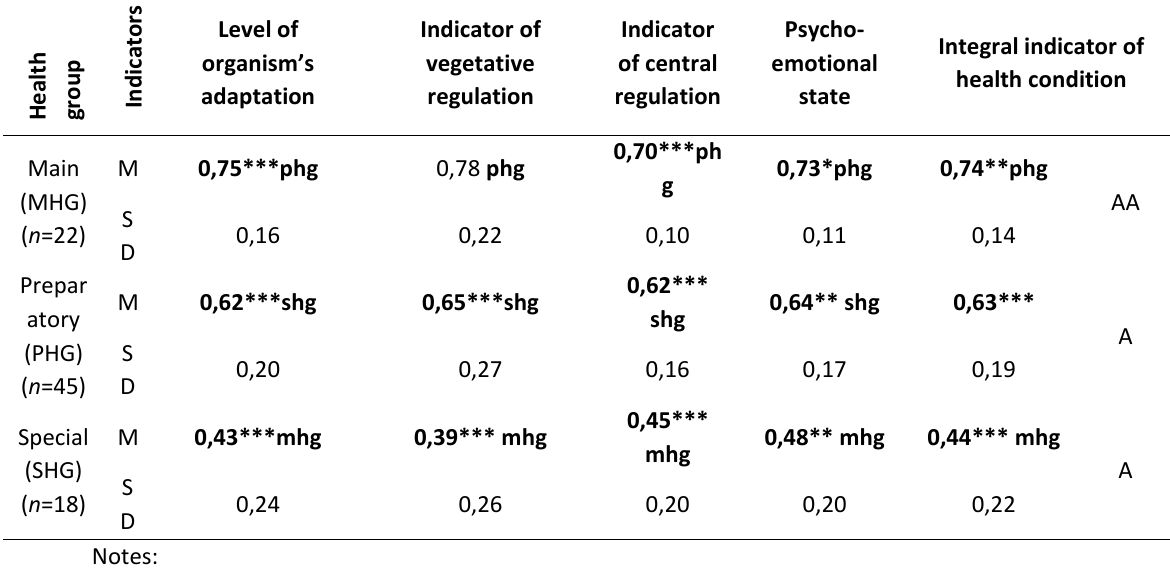
Table 3. Mean values of health functional state (conv.un.) of secondary school age pupils of different health groups